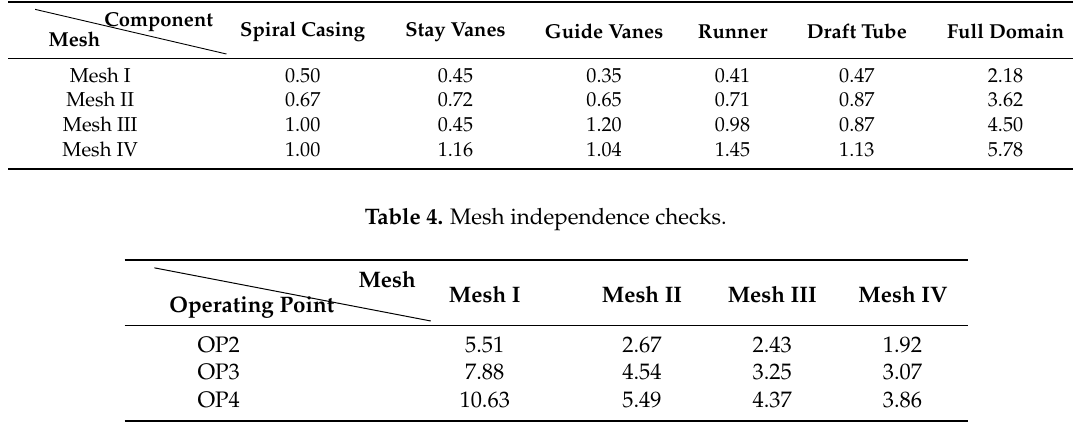
Table 3. Mesh densities (millions).